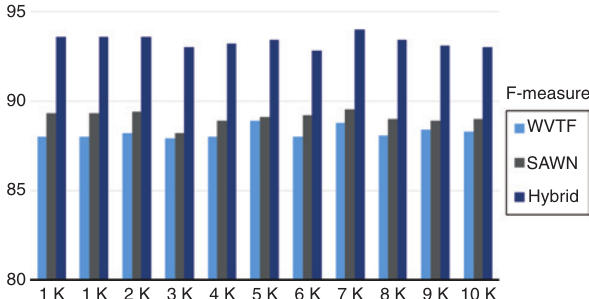
Figure 7: Evaluation of the CBER Approach in Terms of